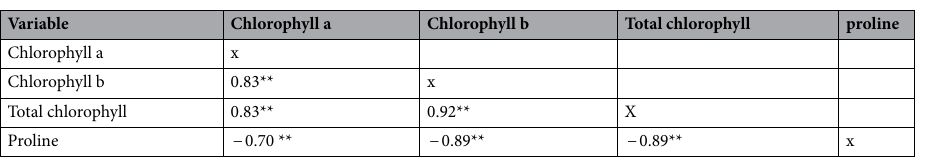
Table 6. Correlations between chlorophyll a, chlorophyll b, total chlorophyll and proline concentration. **Significant at P ≤ 0.01 at probability level.